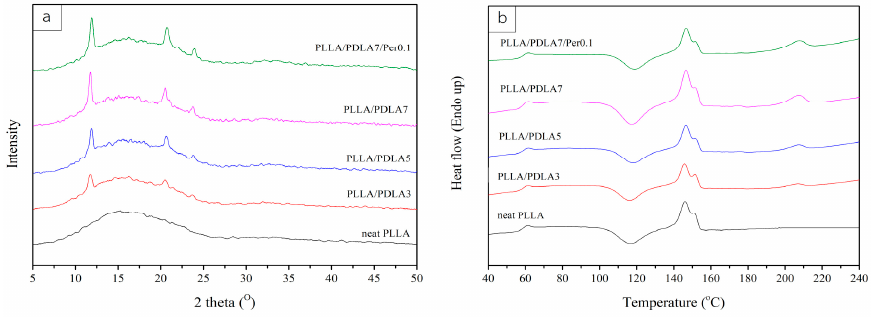
Figure 3. WAXD patterns ( a ) and DSC thermograms of the second heating scan ( b ) of PLLA at different contents of PDLA.